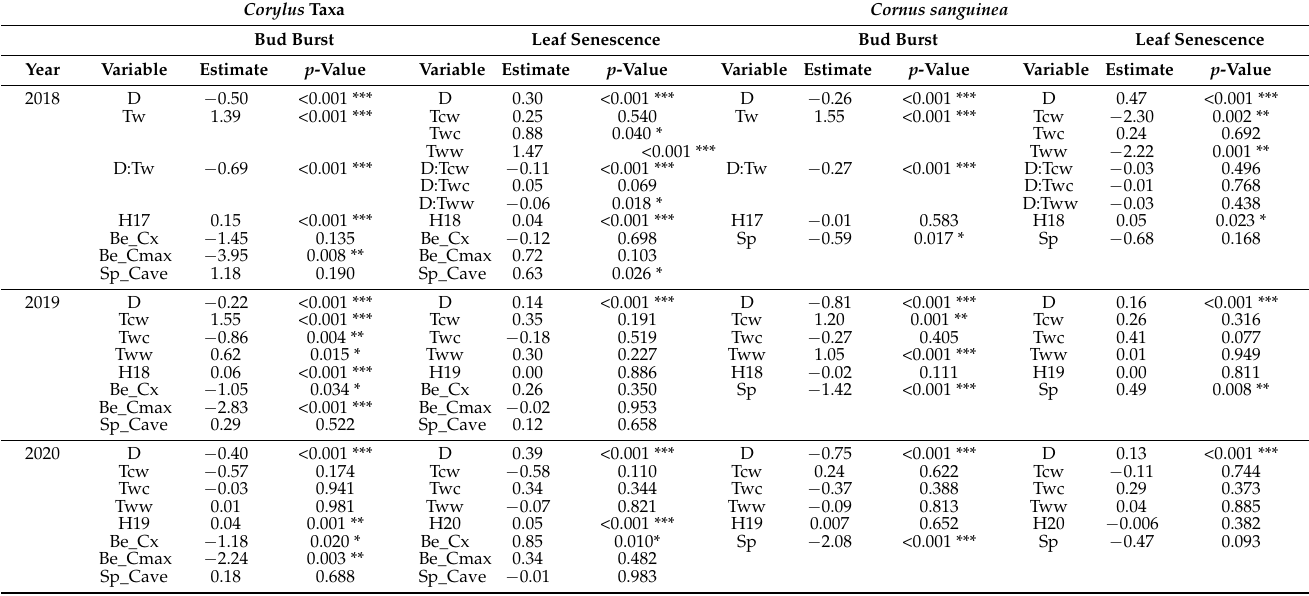
Table 4. Estimates and p -values for the modeled bud burst and leaf senescence for the years 2018 until 2020 for the Corylus taxa and for Cornus sanguinea . For the Corylus taxa, the standard taxon/region is the Belgian Corylus avellana to which the Belgian intermediate forms (Be_Cx), the Belgian Corylus maxima (Be_Cmax), and the Spanish Corylus avellana (Sp_Cave) are compared. For Cornus sanguinea , the Belgian provenance is the standard provenance to which the Spanish provenance (Sp) is compared. The “cold–cold” condition in the temperature treatments during 2018 is the standard to which the other three conditions “cold–warm”, “warm–cold”, and “warm–warm” are compared (Tcw, Twc, and Tww, respectively). For the bud burst in 2018, there were only two conditions, with the “cold” condition as the standard to which the “warm” condition is compared (Tw). H17 to H19 are the plant heights in 2017 to 2019. D is the day of observation.